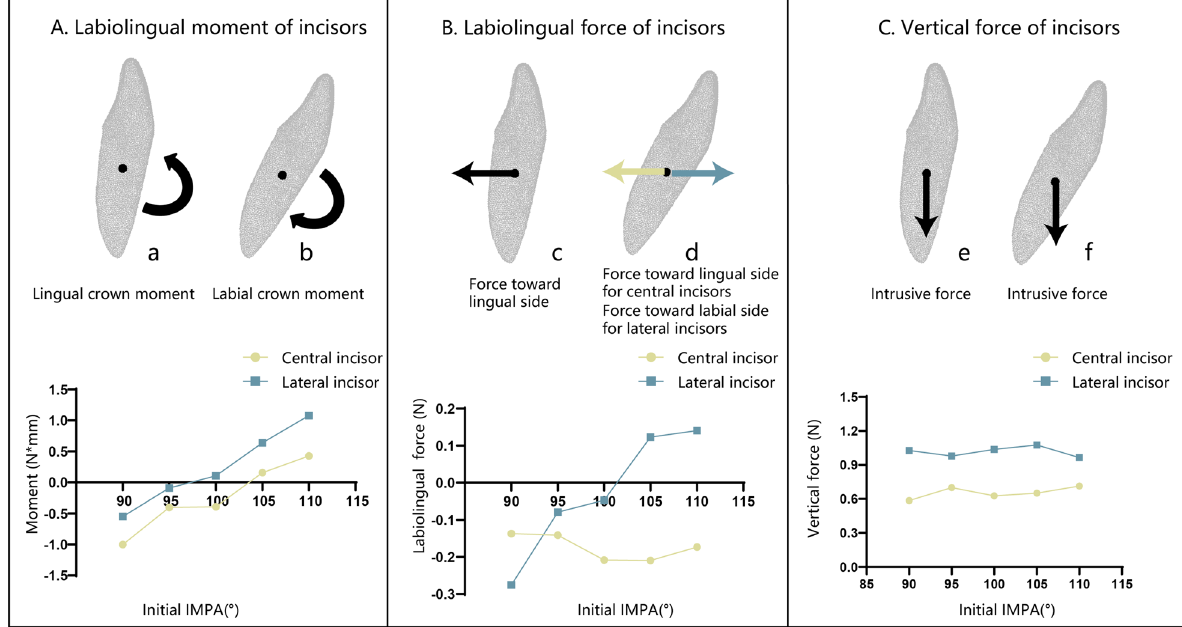
Fig. 4 Force system analysis of incisors with different initial IMPA during the intrusion. The X -axis is the initial IMPA, and the Y -axis is the moment or force. The black dot in the figure is the CR. The black arrow represents the same direction of force or moment on the central incisor and the lateral incisor. The yellow arrow represents the direction of force or moment on the central incisor, and the blue arrow represents that on the lateral incisor. A . Labiolingual moment of incisors: a is the moment of the incisor at 90° (lingual crown moment); b is the moment of the incisor at 110° (labial crown moment). The positive value represents the labial crown moment. When the initial IMPA was less than or equal to 100°, central incisors were subjected to lingual crown moment, and when it was larger than or equal to105°, they were subjected to labial crown moment. When the IMPA was less than or equal to 95°, lateral incisors were subjected to lingual crown moment. When IMPA was greater than or equal to 100°, the moment transformed into labial crown moment for lateral incisors. B . Labiolingual force of incisors: c is the force direction of the incisors at 90° (force toward lingual direction); d is the force direction of the incisors at 110° (force toward lingual direction for central incisors, force toward labial direction for lateral incisors). The positive value represents the force toward the labial direction. The CR of the central incisors was always subjected to force in the lingual direction, and the force value did not change significantly with IMPA. For lateral incisors, when the IMPA was less than or equal to 100°, the CRs of the lateral incisors were subjected to a force in the lingual direction. When it was greater than or equal to 105°, they were subjected to the force toward the labial direction. C . Vertical force of incisors: e is the force direction of the incisors at 90° (intrusive force); f is the force direction of the incisors at 110° (intrusive force). A positive value represents intrusion. The central incisors and lateral incisors were always subjected to vertical intrusive force, and the force value did not change significantly with increasing IMPA. The intrusive force of the lateral incisors was always greater than that of the central